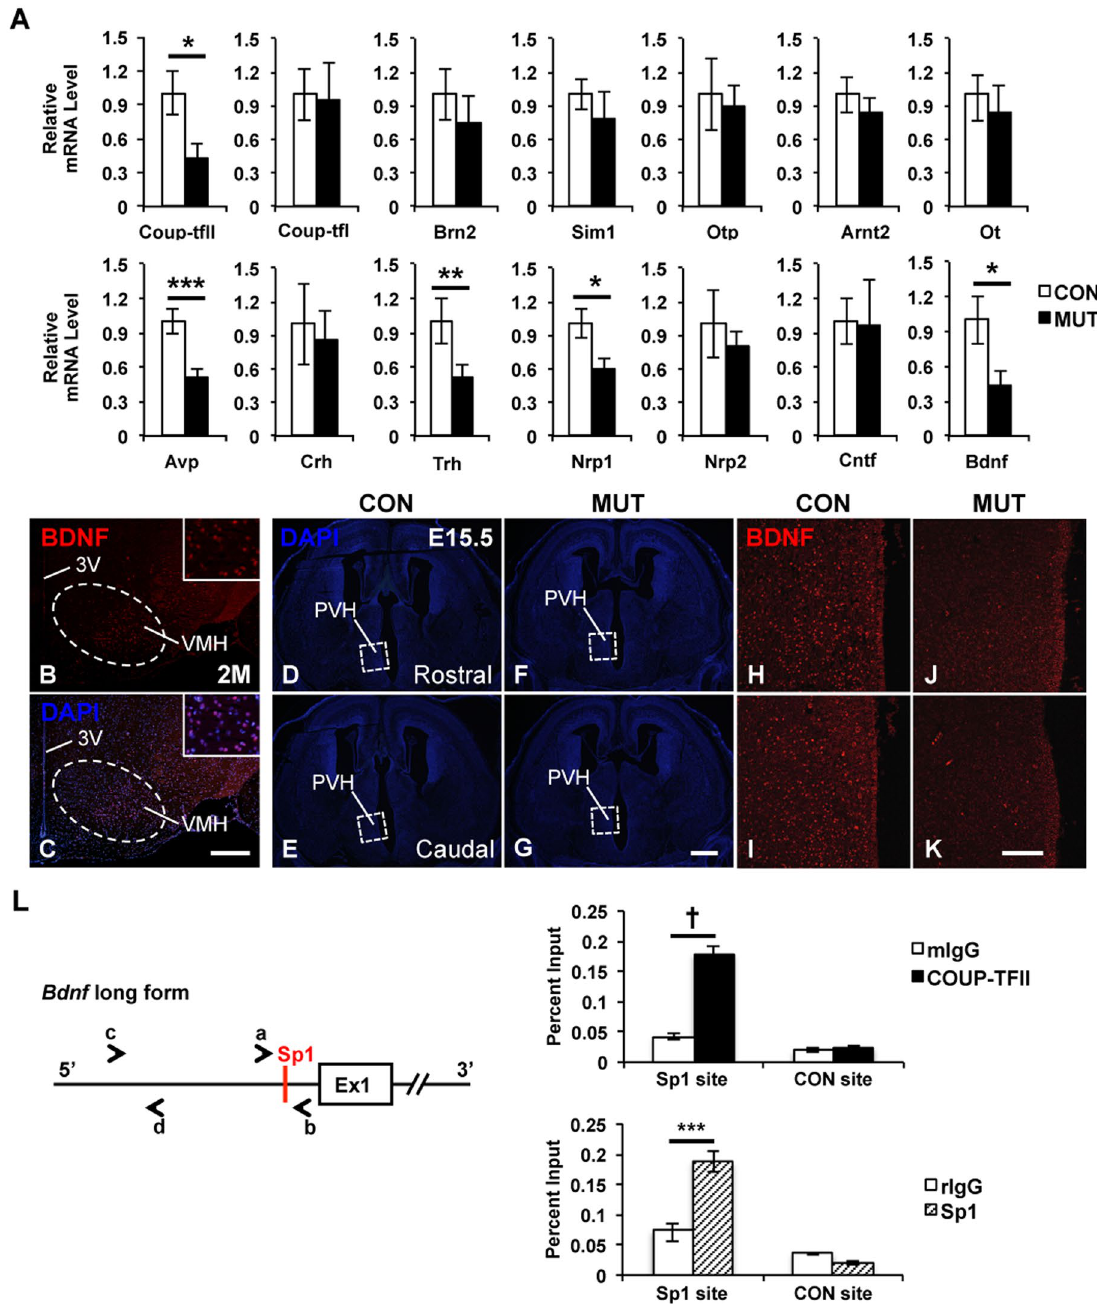
Figure 6. Expression of Bdnf and Nrp1 is reduced in the COUP - TFII mutant embryo, and Bdnf is a downstream target of COUP-TFII. ( A ) Real-time quantitative PCR data with samples from the ventral forebrain of the control (n = 4) and mutant (n = 3) embryos at E14.5. The expression of COUP - TFII , Avp , Bdnf , Nrp1 and Trh transcripts is significantly reduced in the mutant. A BDNF-specific antibody detects the expression of BDNF in the cytoplasm of neurons at the ventro-lateral region of the mouse VMH nucleus at 2 M ( B , C ). DAPI staining images of coronal sections with the PVH region in the control ( D , E ) and the mutant ( F , G ) at E15.5. Compared with the control ( H , I ), the expression of BDNF protein is noticeably reduced in the prospected mutant hypothalamus at E15.5 ( J – K ). L, An evolutionarily conserved Sp1 binding site is identified at the promoter region of the long form of the Bdnf gene. Primers a/b and c/d were used to amplify the Sp1 locus and a 2 kb up-stream non-Sp1 control locus, respectively. In chromatin immunoprecipitation assays, the binding of both COUP-TFII and Sp1 protein is enriched at the conserved Sp1 site but not at the negative control site. 3 V, third ventricle; PVH, paraventricular nucleus of hypothalamus; VMH, ventromedial nucleus of hypothalamus. Three independent assays were performed in each real-time quantitative PCR experiment. The data indicate the mean ± SD. Student’s t-test, * P < 0.05; ** P < 0.01; *** P < 0.005; † P < 0.001. Scale bar, ( B , C ) 300 μ m; ( D – G ) 500 μ m; ( H – K ) 100 μ